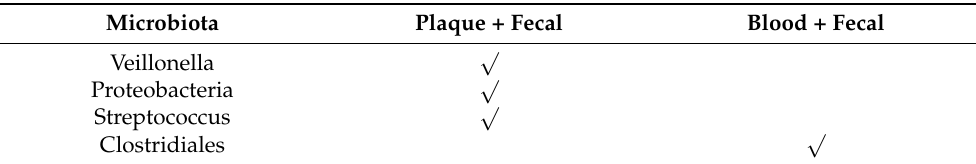
Table 6. Microbiota populations common to at least two body